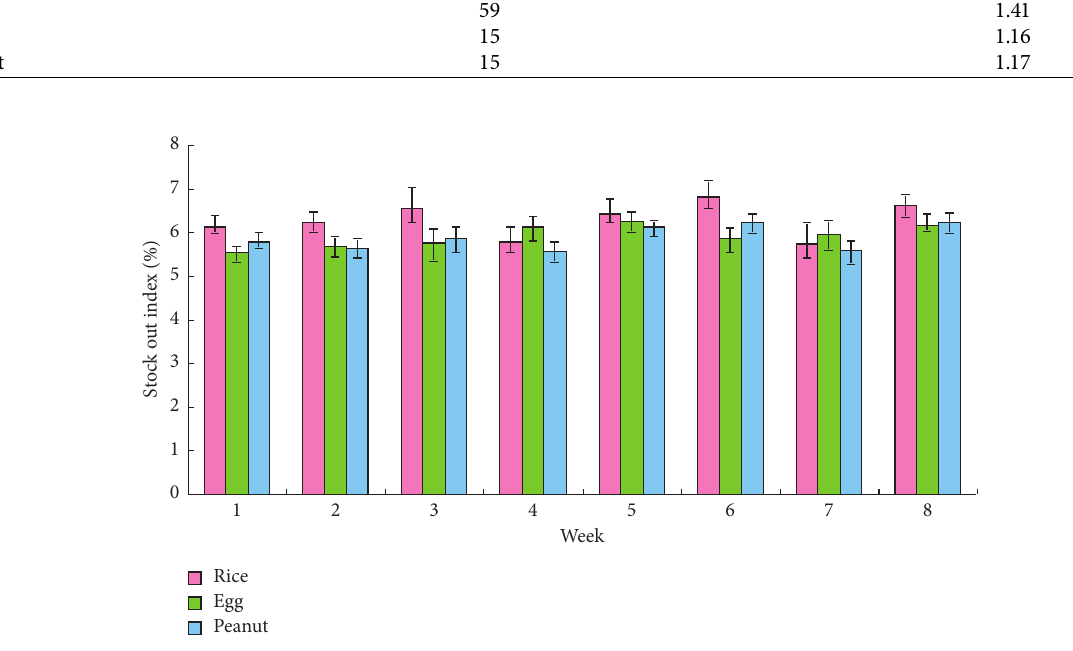
Figure 7: Comparison results of stock-out index of different types of agricultural